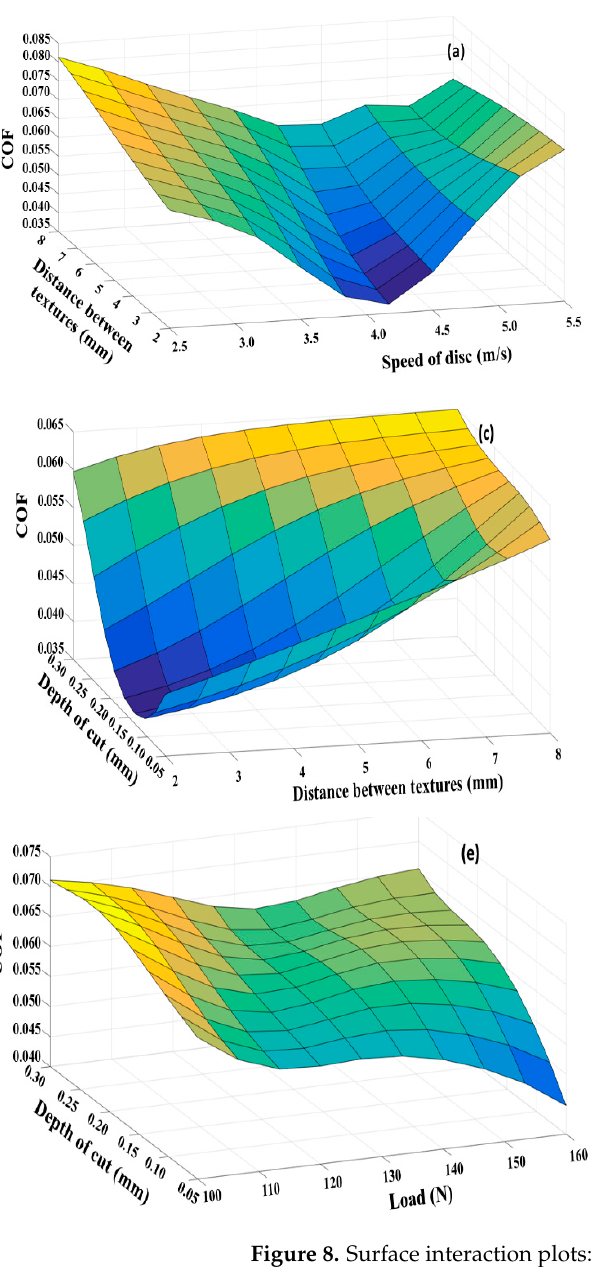
Figure 8. Surface interaction plots: ( a – c ) circular grooves; ( d – f ) perpendicular grooves.